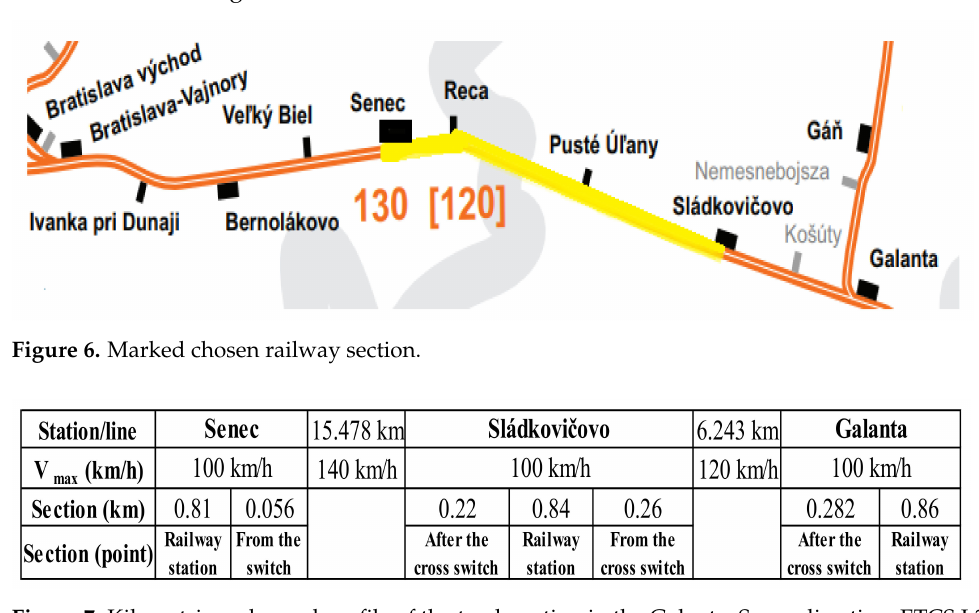
Figure 7. Kilometric and speed profile of the track section in the Galanta–Senec direction, ETCS